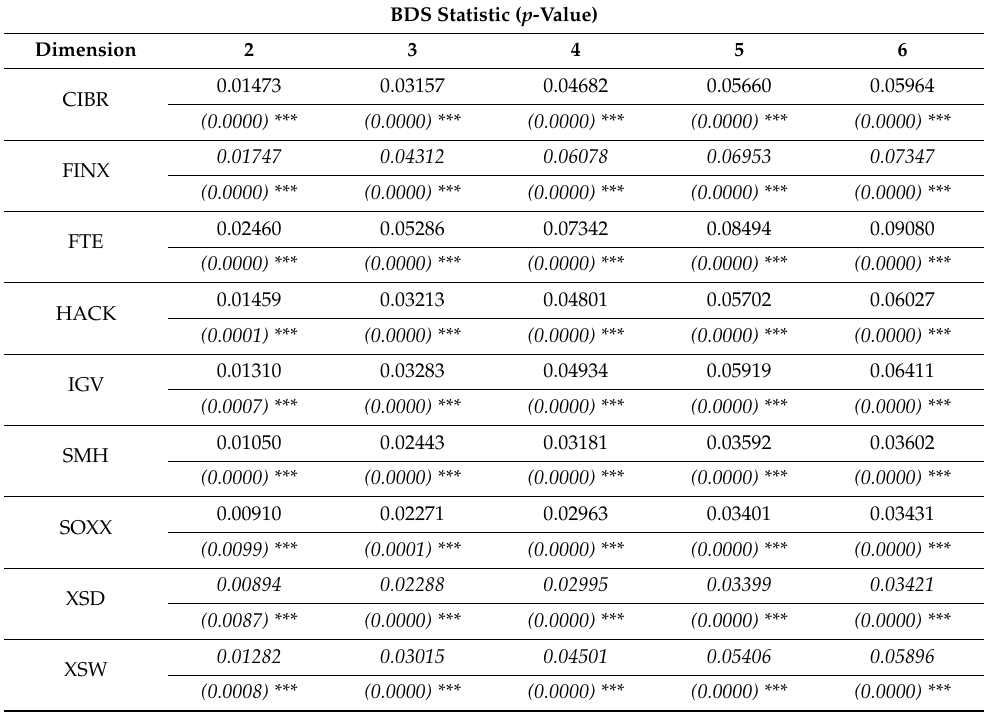
Table A2. BDS Test for Nonlinearity for ETF excess return.